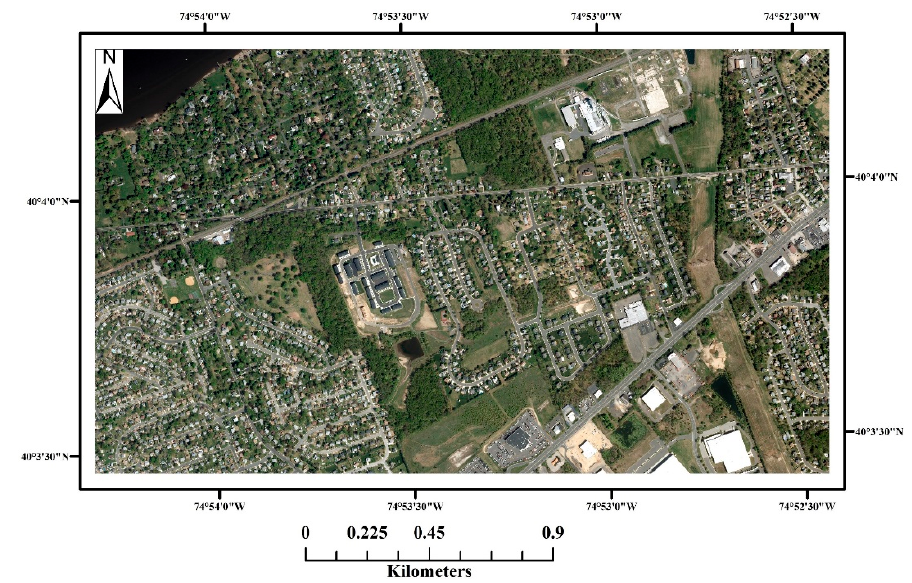
Figure 1. 30 cm aerial image covering an urban area in Calhoun, Illinois, USA.